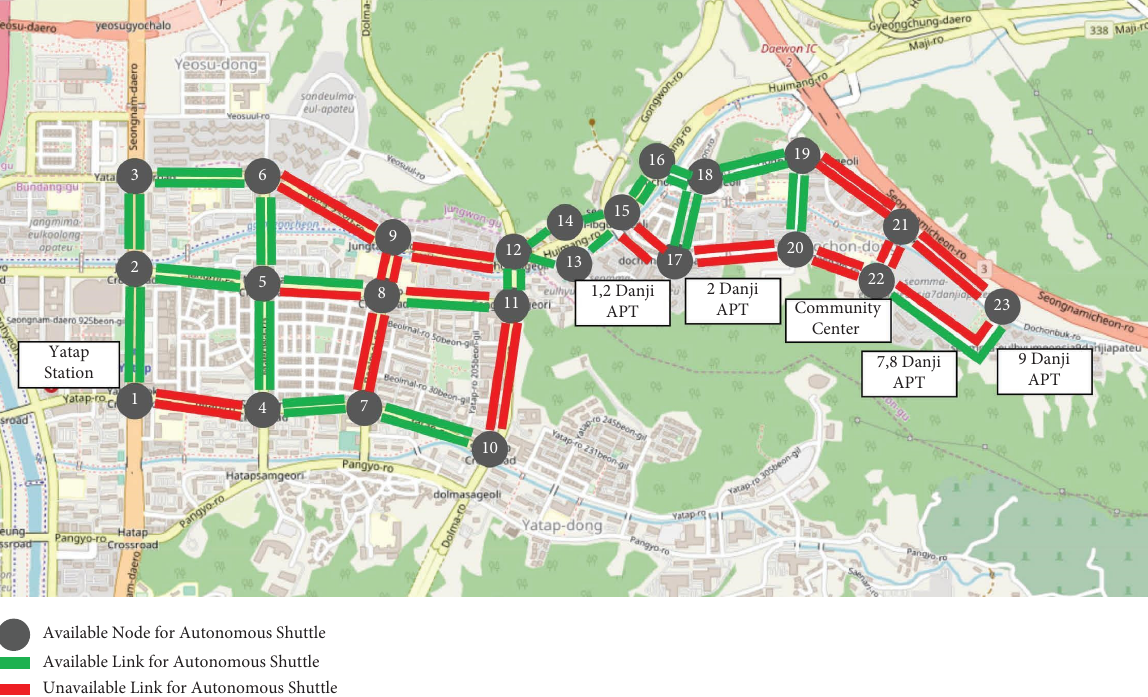
Figure 20: Result of autonomous shuttle operation feasibility analysis based on ODD for < residence-I > major